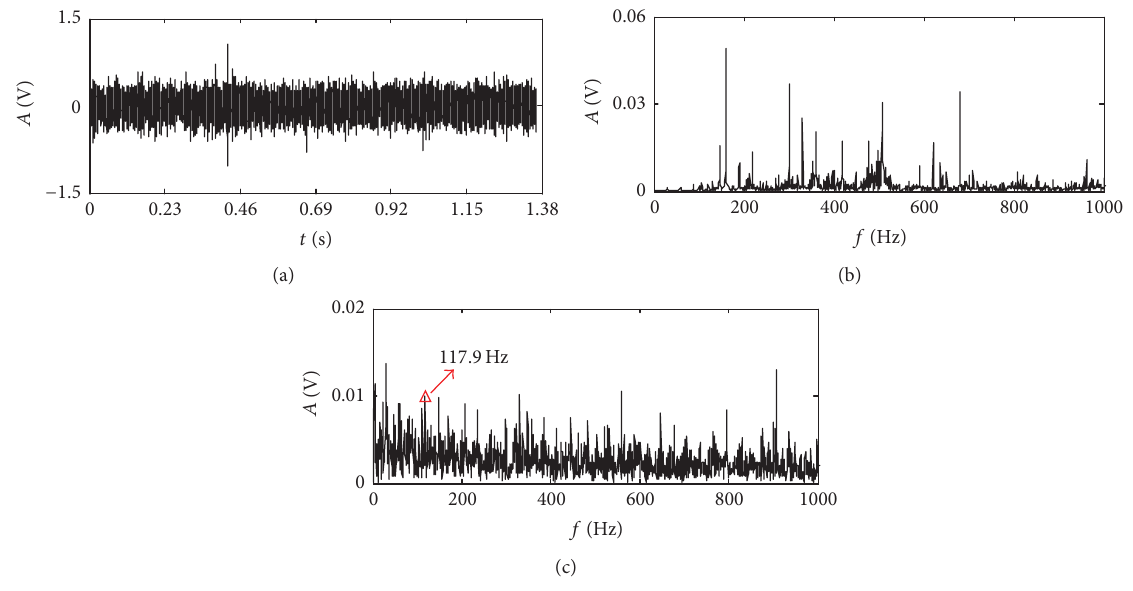
Figure 6: Vibration signal of bearing: (a) the time waveform; (b) the frequency spectrum; (c) the envelop spectrum.